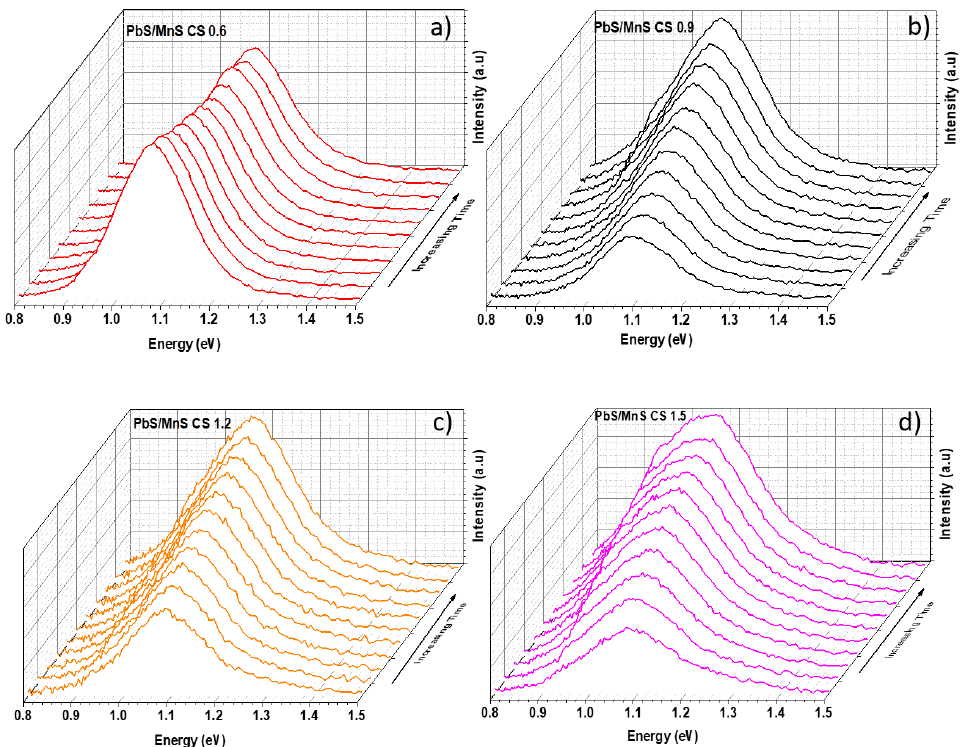
Figure 5. PL spectra of PbS / MnS ( a ) CS 0.6, ( b ) CS 0.9, ( c ) CS 1.2 and ( d ) CS 1.5 exposed to laser of power p = 100 mW and time exposure up to 40 min at room temperature.